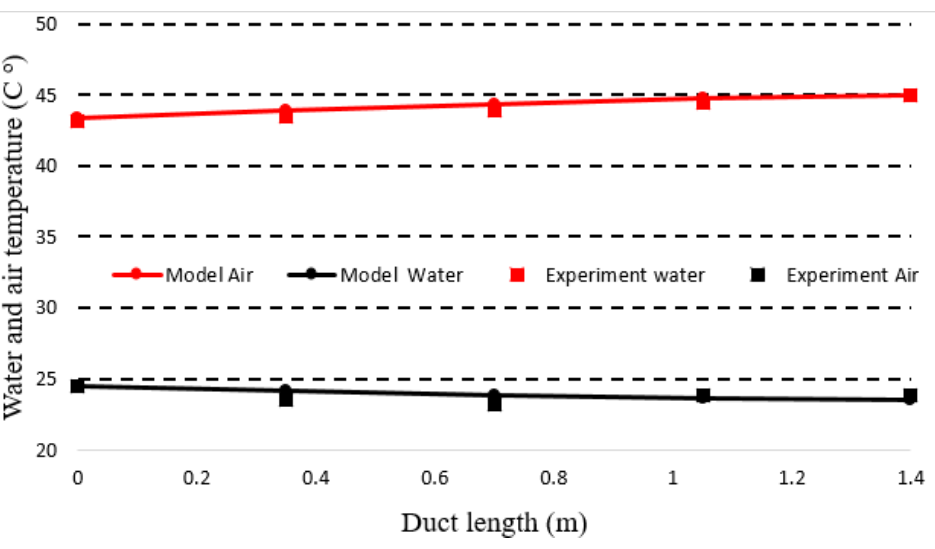
Figure 15. Experimental and simulated air and water temperatures on 22 June at 13:50. The RMS% is 0.78% and 3.4% for air temperature and 1.9% and 1.58% for water tem- perature for Figures 15 and 16, respectively.